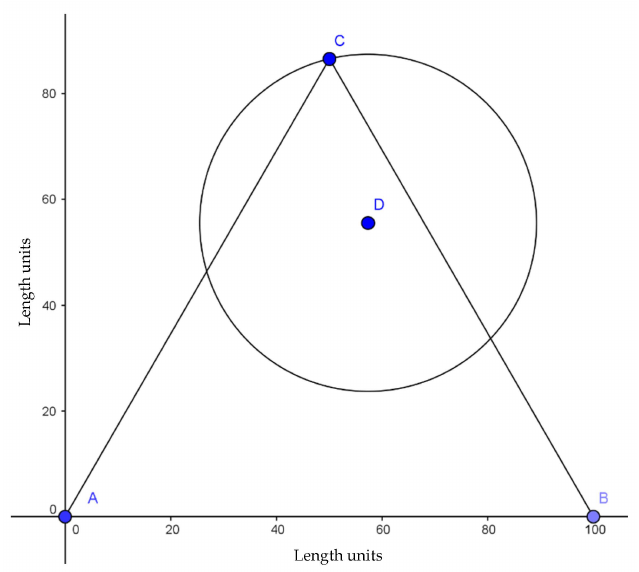
Figure 6. Wave front of the acoustic emission collected by the nearest Sensor